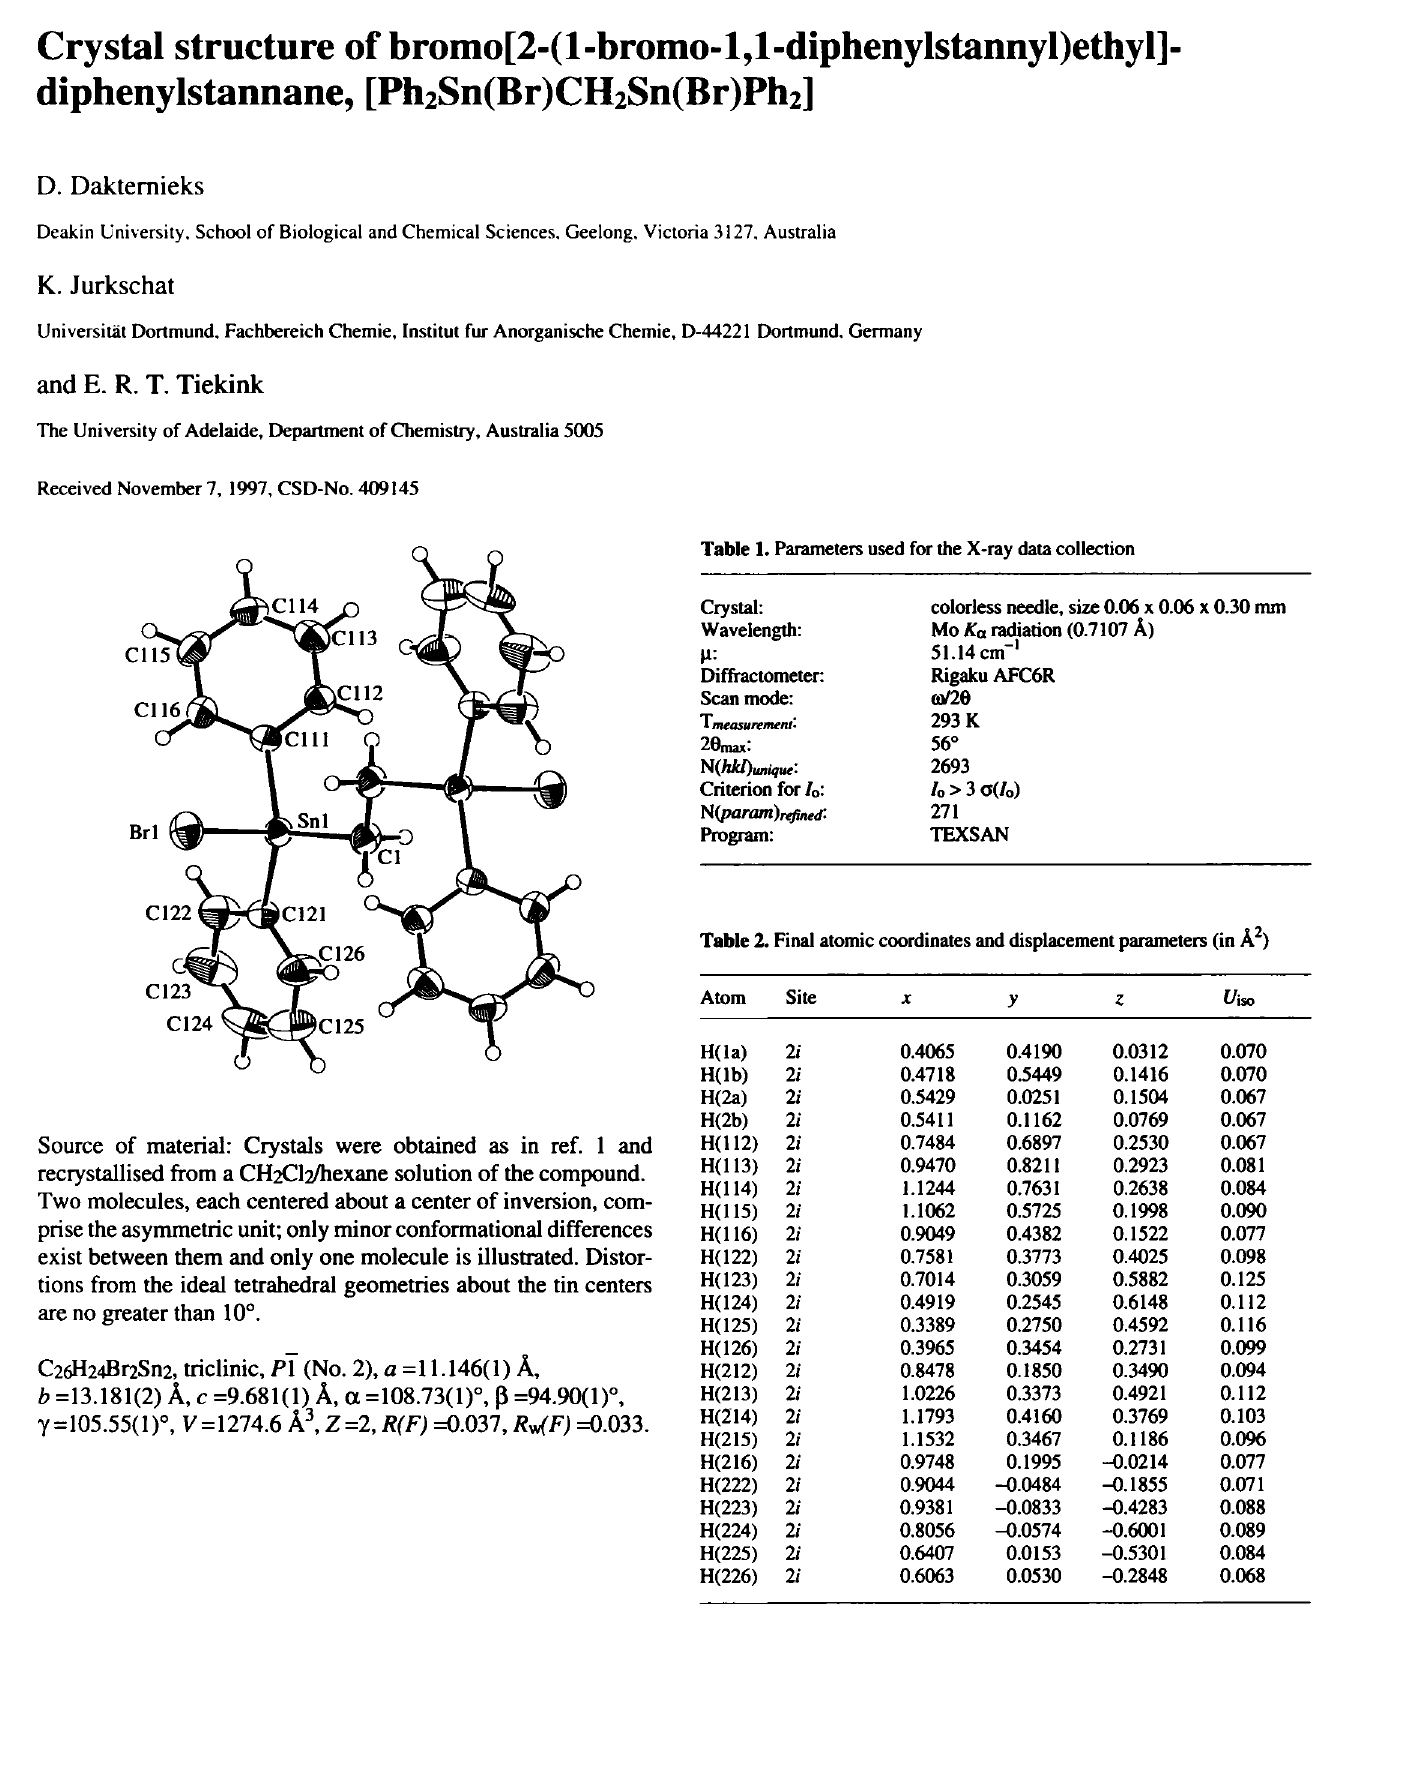
Table 1. Parameters used for the X-ray data collection Crystal: